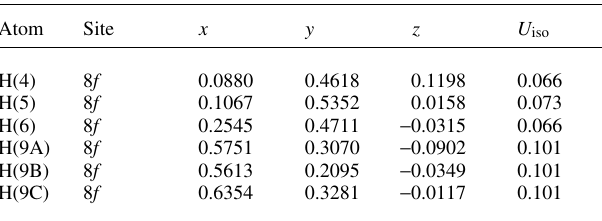
Table 2. Atomic coordinates and displacement parameters (in Å 2 )